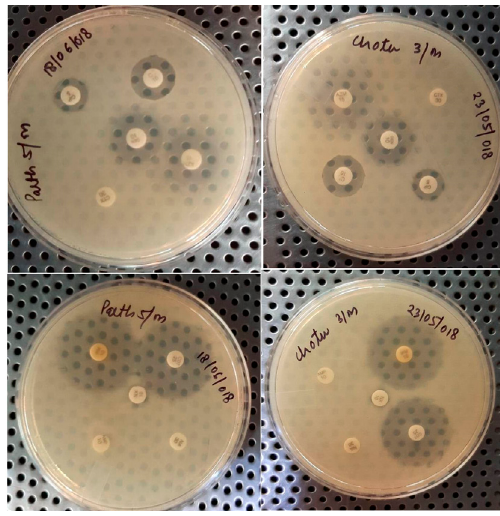
Fig. 7. Antibiotic Sensitivity test depicting zone of inhibition of ten antibiotics used